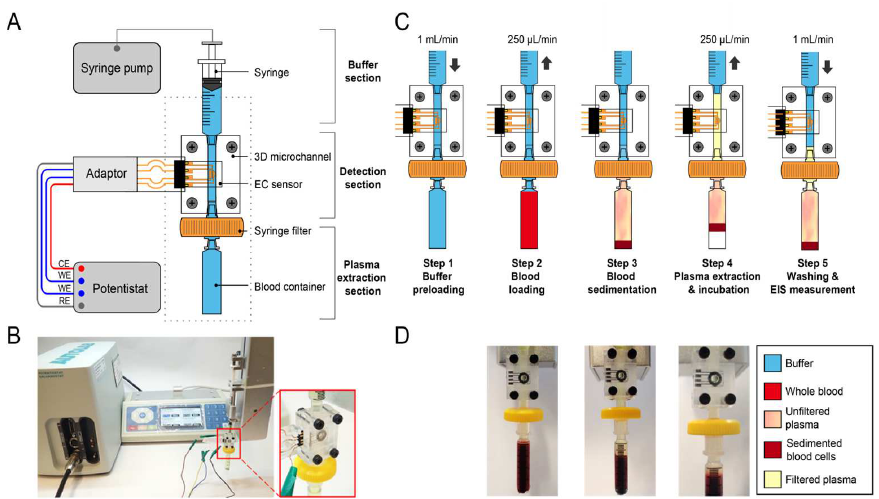
Figure 1. ( A ) The schematic and ( B ) a photo of the microfluidic platform. The red-framed inset shows the composition of the microchannel with an embedded electrochemical (EC) sensor, connecting the blood container and the buffer syringe. ( C ) The operation protocol of the microfluidic platform: (1) buffer preloading; (2) blood loading; (3) blood sedimentation; (4) plasma extraction and incubation; (5) washing and electrochemical impedance spectroscopy (EIS) measurement. ( D )